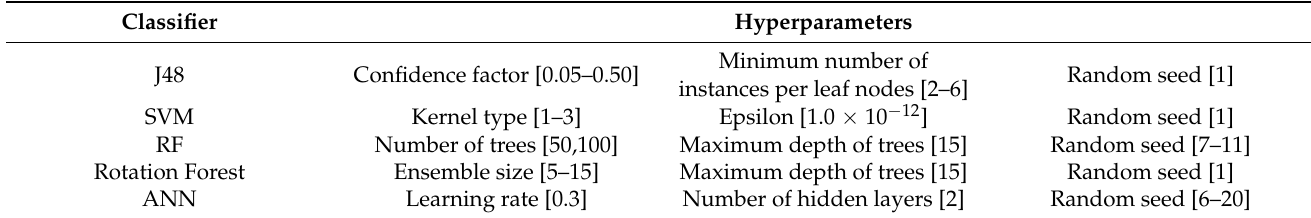
Table 3. The ranges of the hyperparameters of the